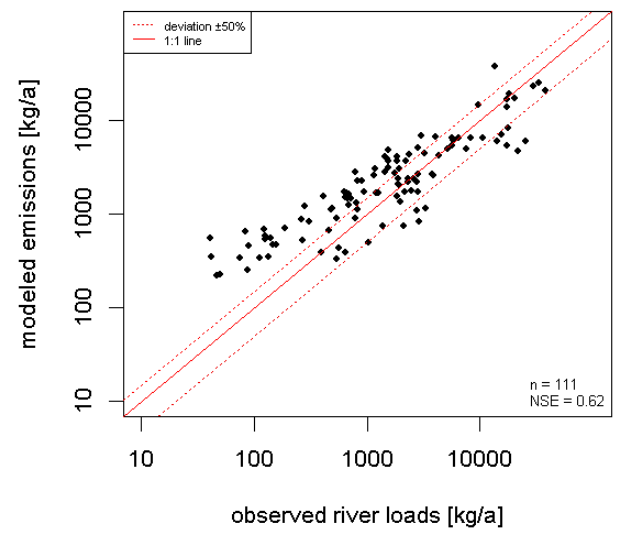
Figure 7. Comparison of observed river loads to modeled copper emissions for the years 2012–2014 (NSE: Nash Sutcliff Efficiency coefficient). (NSE: Nash Sutcliff Efficiency